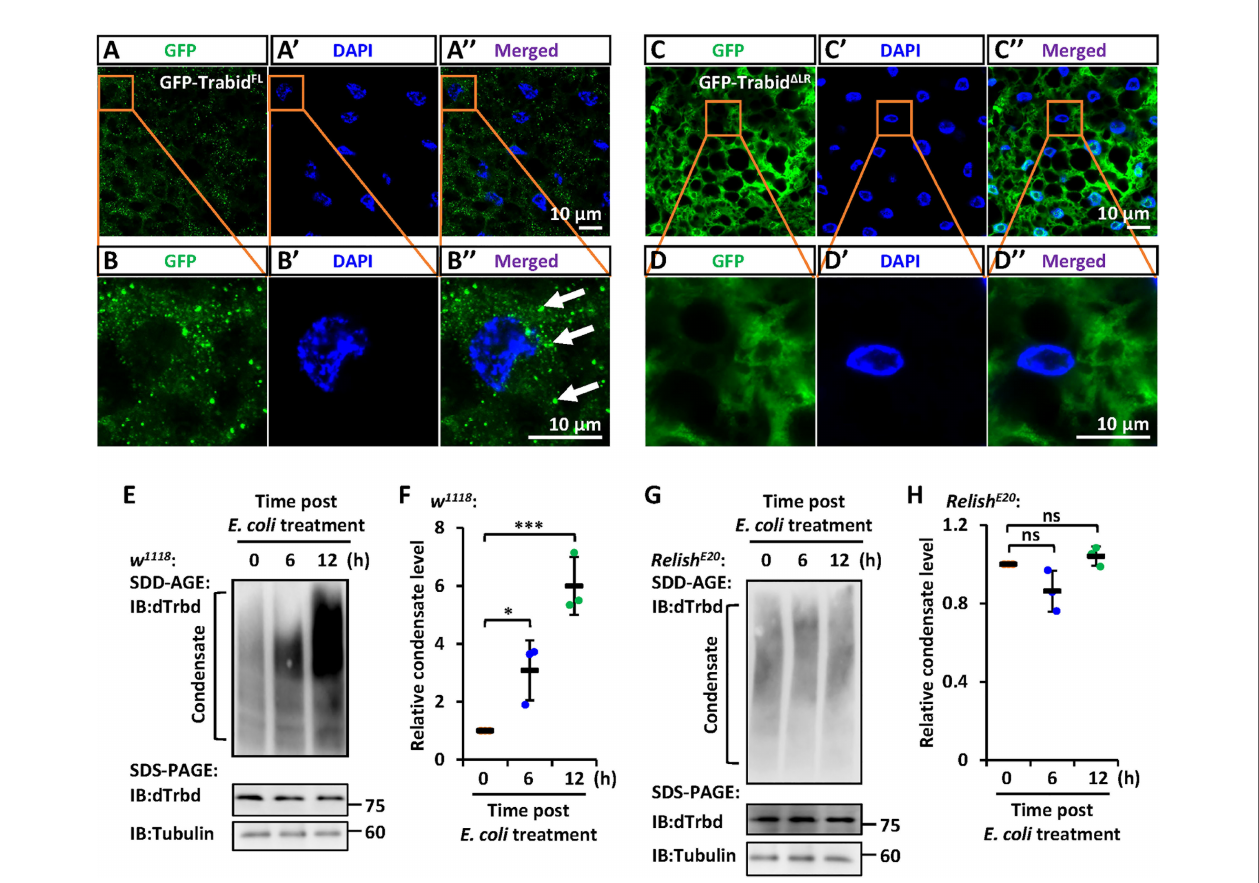
FIGURE 4 | IMD signaling regulates the LR-mediated condensation of dTrbd. (A – D) Confocal imaging of fat bodies dissected from larvae including c564 ts >GFP- dTrbd FL (A, B) and c564 ts >GFP-dTrbd D LR (C, D) . Scale bars, 10 m m. (E, F) Male w 1118 adults were infected with freshly-cultured E. coli . At various time points (0, 6, and 12 h) post infection, fat bodies were dissected and subjected to SDD-AGE (upper panel in E ) or SDS-PAGE (lower panel in E ) assays. Densitometry analysis to quantify the condensate level of samples in (E) is shown in (F) . (G, H) Similar as in (E, F) except the Relish E20 mutants were used. In (F, H) data are shown as mean ± SD. *p < 0.05; ***p < 0.001; ns, not signi fi